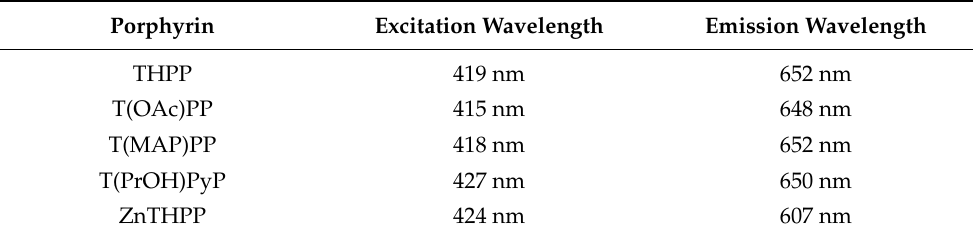
Table 8. Wavelengths for excitation and emission, for the porphyrins dissolved in methanol with 10% aqueous